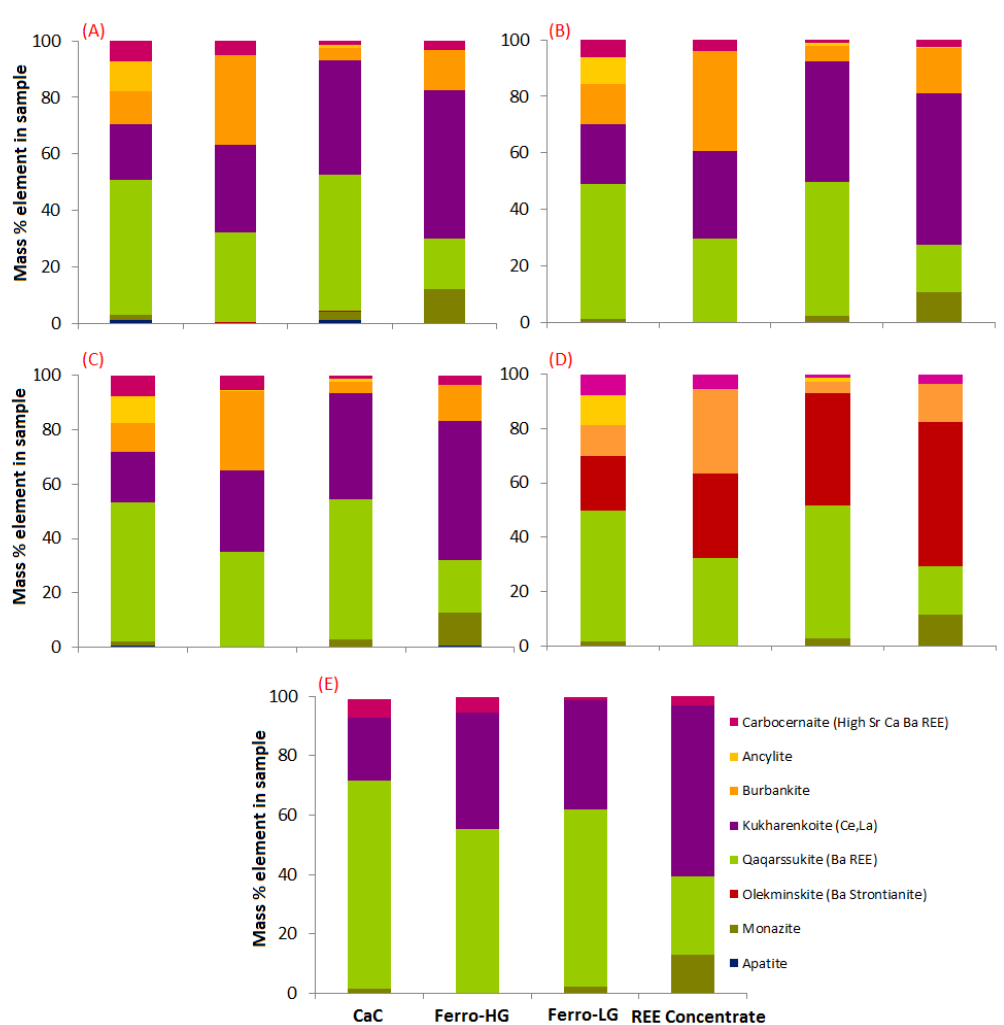
Figure 7. Ce ( A ), La ( B ), Pr ( C ), Nd ( D ), and Sm ( E ) deportment in REE-bearing minerals.